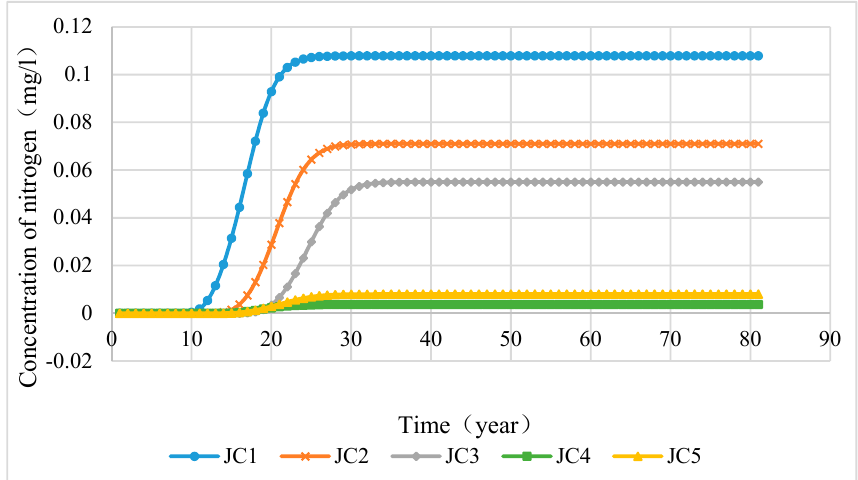
Figure 16. Ammonia nitrogen concentration changing curves of five monitoring wells under the joint action of strong pumping wells and hydraulic interception